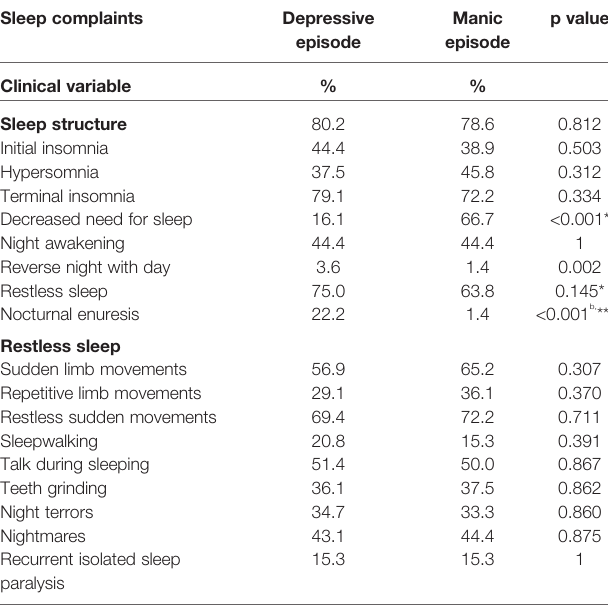
a, *Sleep complaints were obtained by psychiatric clinical interview using structure scales to analyze sleep patterns comparing depressive and mania episodes. ns, non signi fi cant. b, **Qui Square test, p <